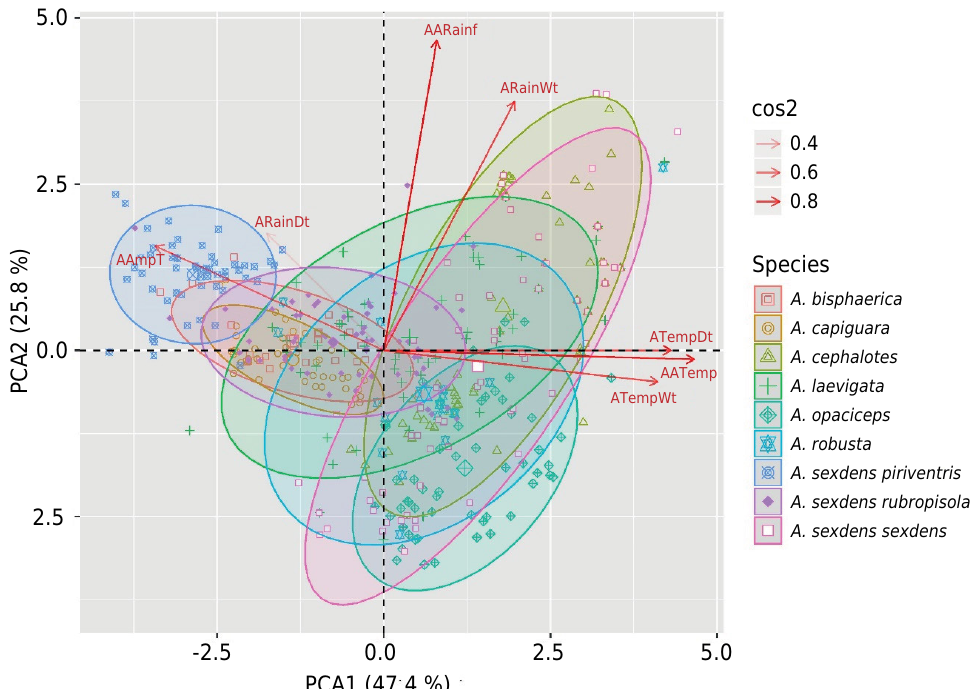
Figure 4. Principal Component Analysis (PCA) of relations between the Atta species points and climatic aspects. The variables are annual average rainfall (AARainf), average rainfall wetter trimester (ARainWt), average rainfall driest trimester (ARainDt), annual amplitude temperature (AAmpT), annual average temperature (AATemp), average temperature wetter trimester (ATempWt), and average temperature driest trimester (ATempDt). Pearson correlation of each vector is indicated in